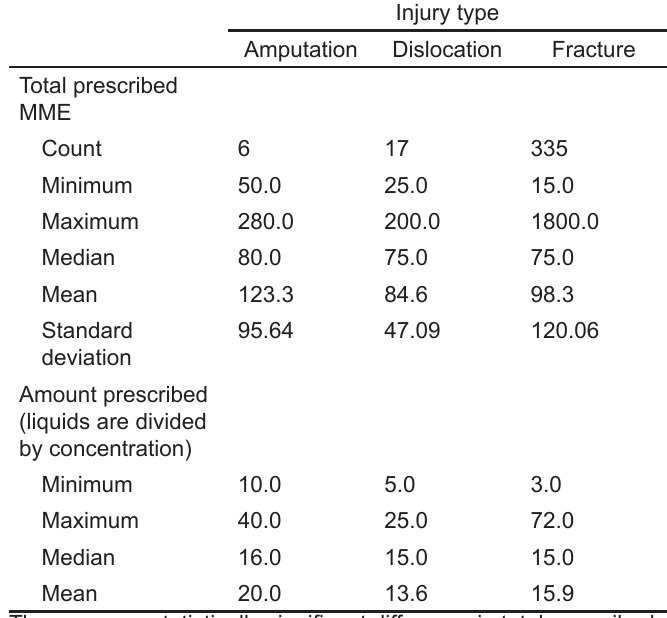
Table 2. Association between injury type and opioids